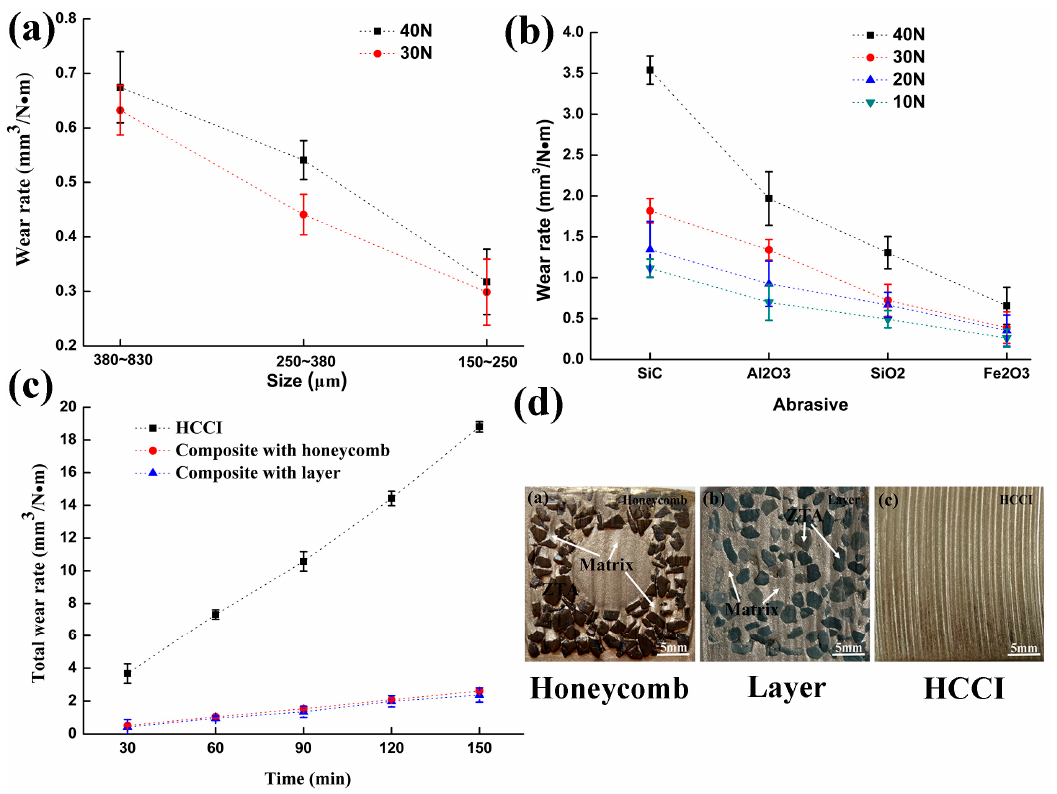
Figure 6. Three-body abrasive wear rates of the composites: ( a ) In the case of different abrasive sizes in quartz sand, ( b ) In the case of different abrasive particles, ( c ) the HCCI and the composite in quartz sand, ( d ) Different structures of the worn surface.